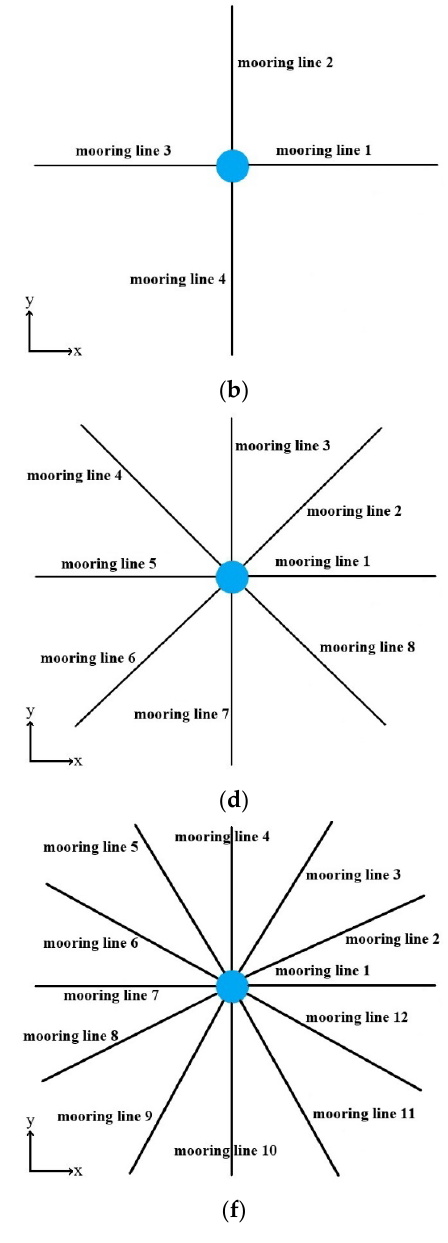
Figure 15. Influence of the number of mooring lines on the mooring system. ( a ) The coupled system for analysis with four mooring lines; ( b ) schematic diagram of the design of four mooring lines; ( c ) the coupled system for analysis with eight mooring lines; ( d ) schematic diagram of the design of eight mooring lines; ( e ) the coupled system for analysis with twelve mooring lines; ( f ) schematic diagram of the design of twelve mooring